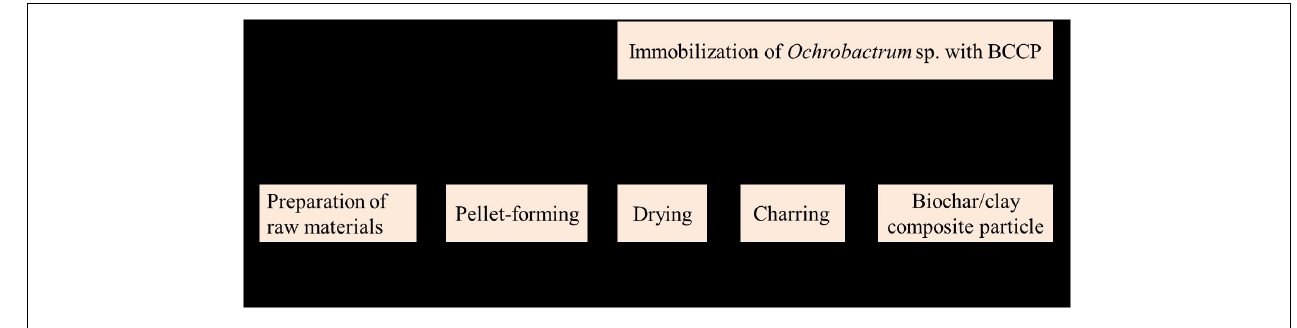
FIGURE 1 | Calcined program of BCCP and immobilization of Ochrobactrum sp.